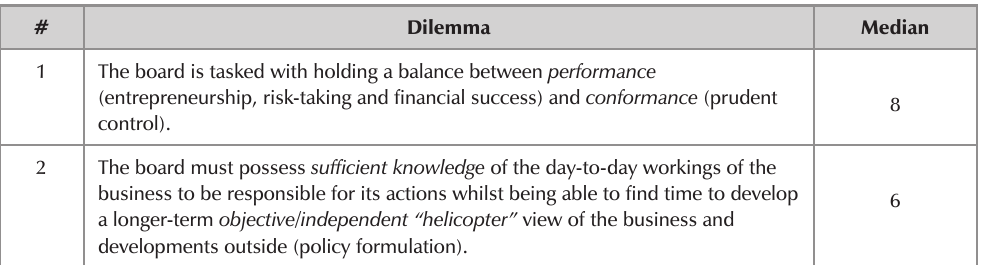
Final list of core corporate governance dilemmas facing